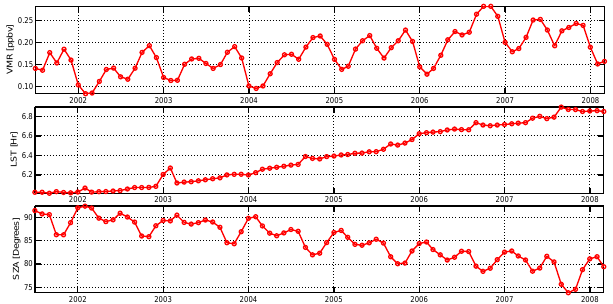
Fig. 4. Monthly averaged SMR ClO concentrations as a function of time (for binned profiles, 20 ◦ S–20 ◦ N, 35–45km), taken for ascending node scans. Middle, SMR LST as a function of time. Lower, SMR SZA as a function of time.